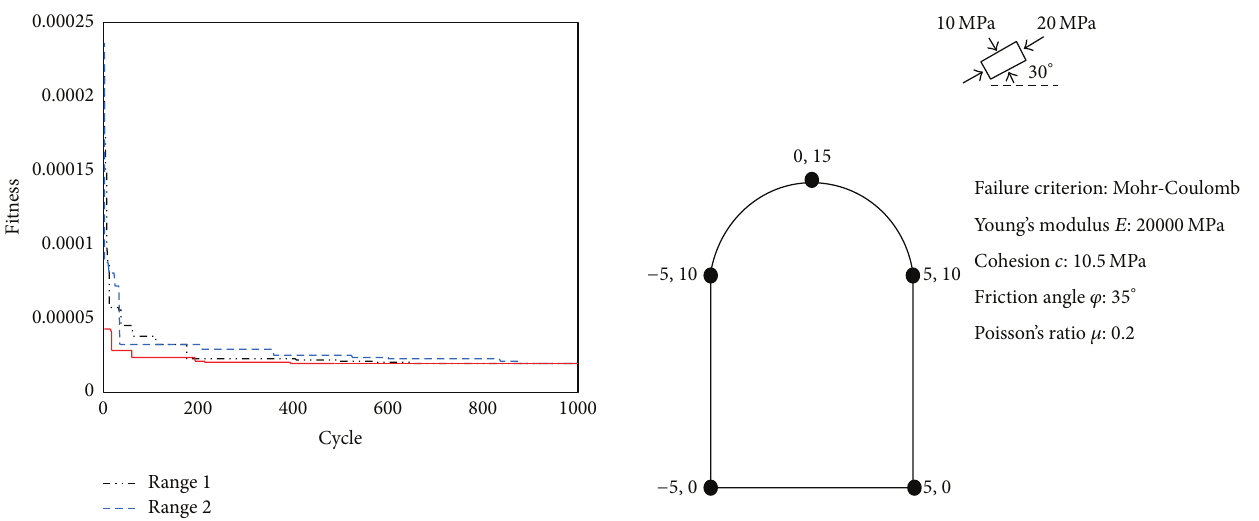
Figure 10: The cross section of tunnel and parameters.